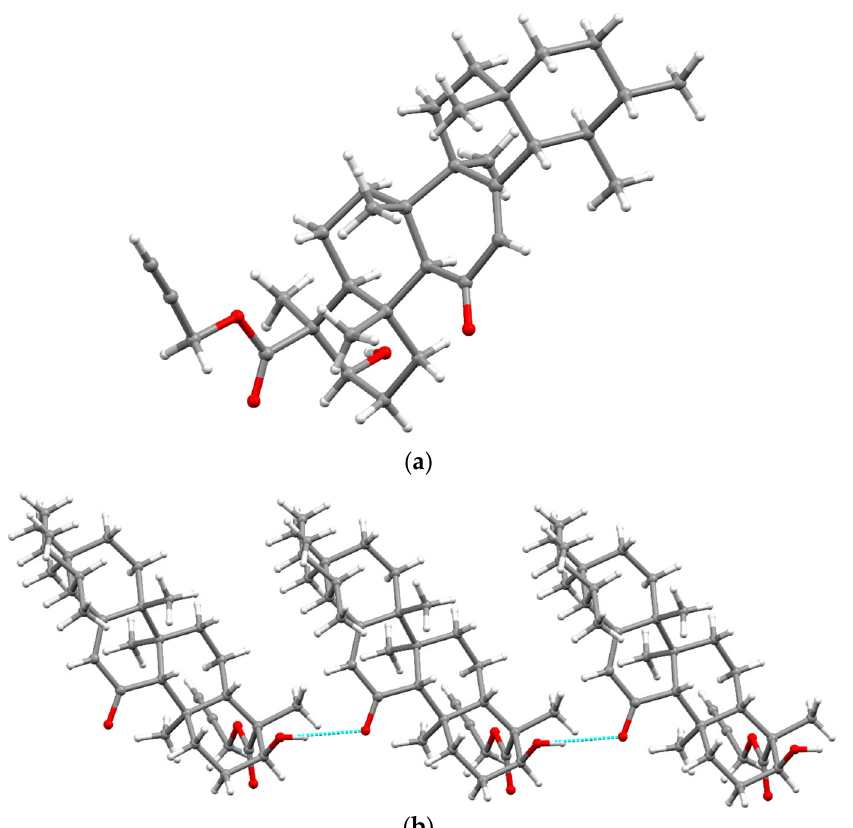
Figure 2. X-ray crystal structure of compound 4 ( a ). Hydrogen bonding in 4 ; H-bonds are shown in blue ( b